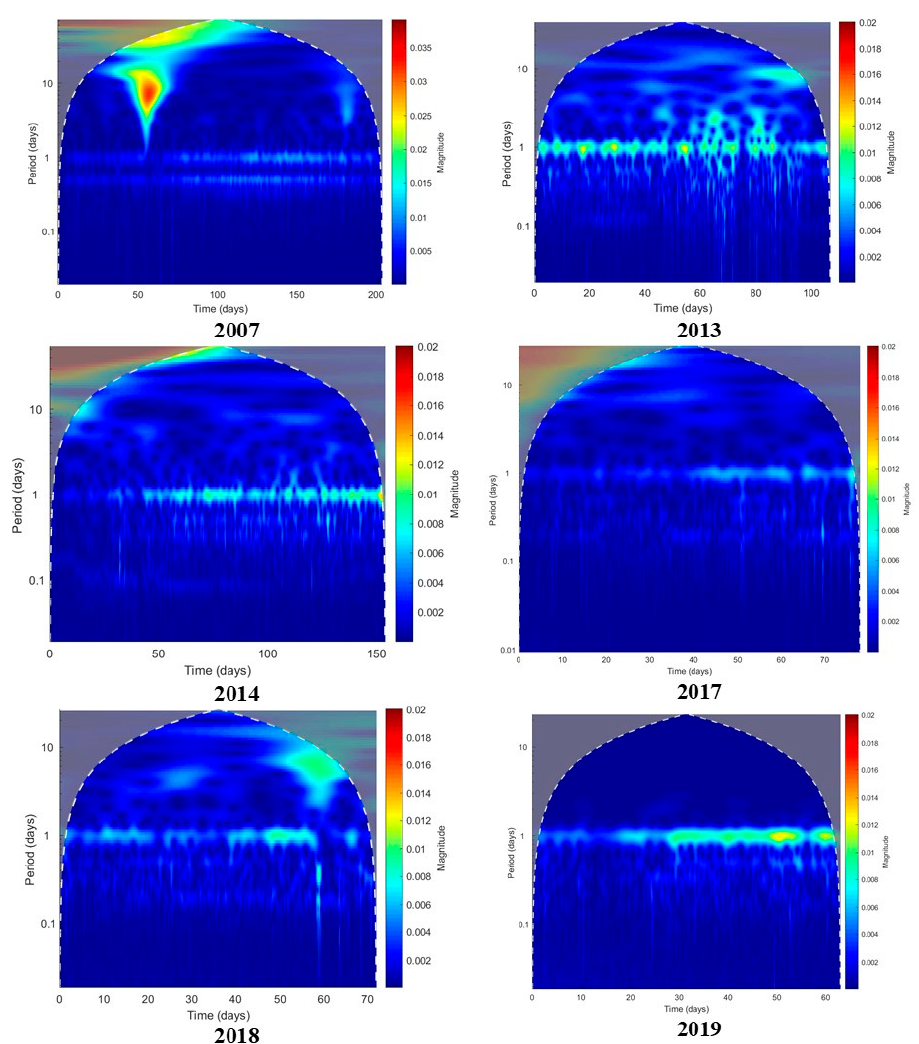
Figure 3. CWT Magnitude Scalograms from the stage data during the flow recession periods indicating the existence of diurnal and semi-diurnal oscillation signals in Koiliaris River. An example of the tidal constituents for the ER and LR period of the 2019 and 2018 data is presented in Figure 4 and Supplementary Figure S4, respectively.